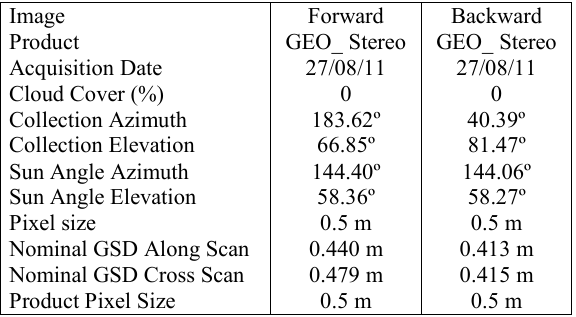
Table 1. Characteristics of the GeEye-1 Stereopair.